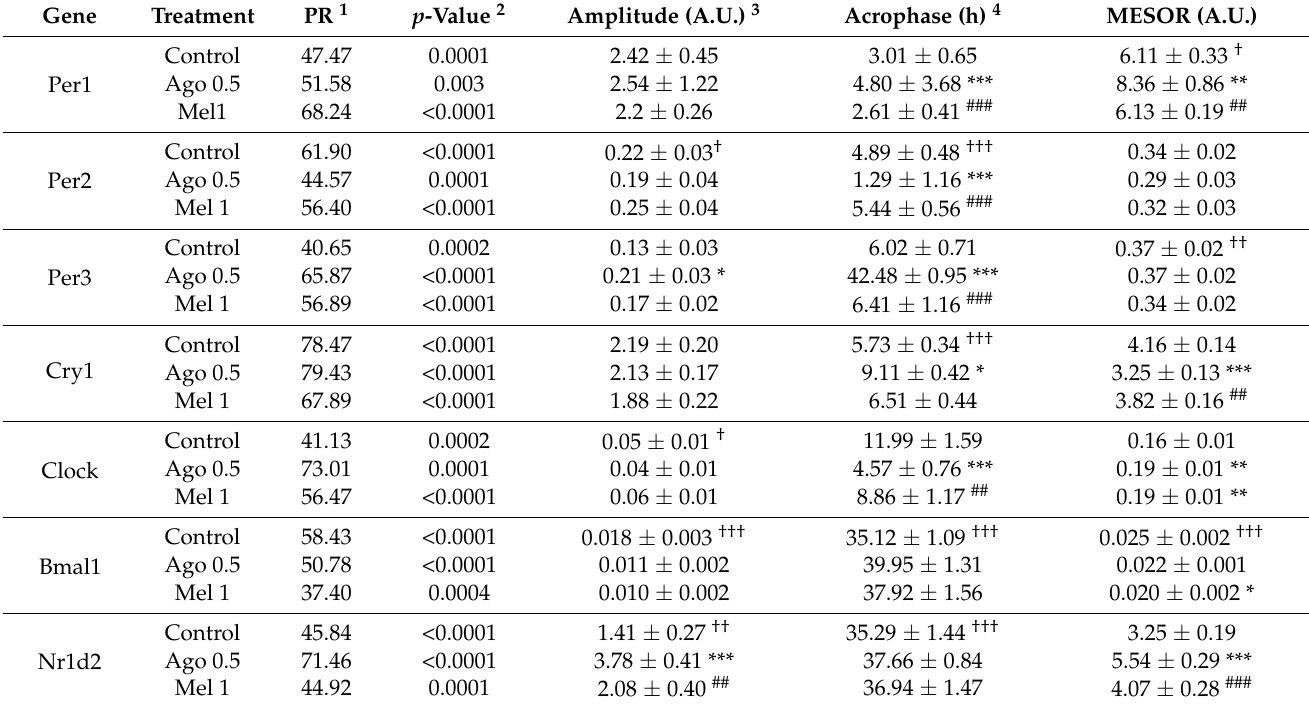
Table 3. Results of the cosinor analysis of Sirt1-gene expression after agomelatine or melatonin treat- ment in the HCT-116 and HCT-116-p53-null cell lines. MESOR of the gene, while agomelatine delayed this parameter. By contrast, agomelatine induced an advance in phase in the acrophase and decreased the MESOR of the PRX1 in the HCT-116-p53-null cells (Figure 8b), while melatonin did not induce changes in any of the rhythmic parameters in this gene (Table 4). Table 2. Results of the cosinor analysis of the clock genes’ expression after agomelatine or melatonin treatment in the HCT-116-p53-null cell line.